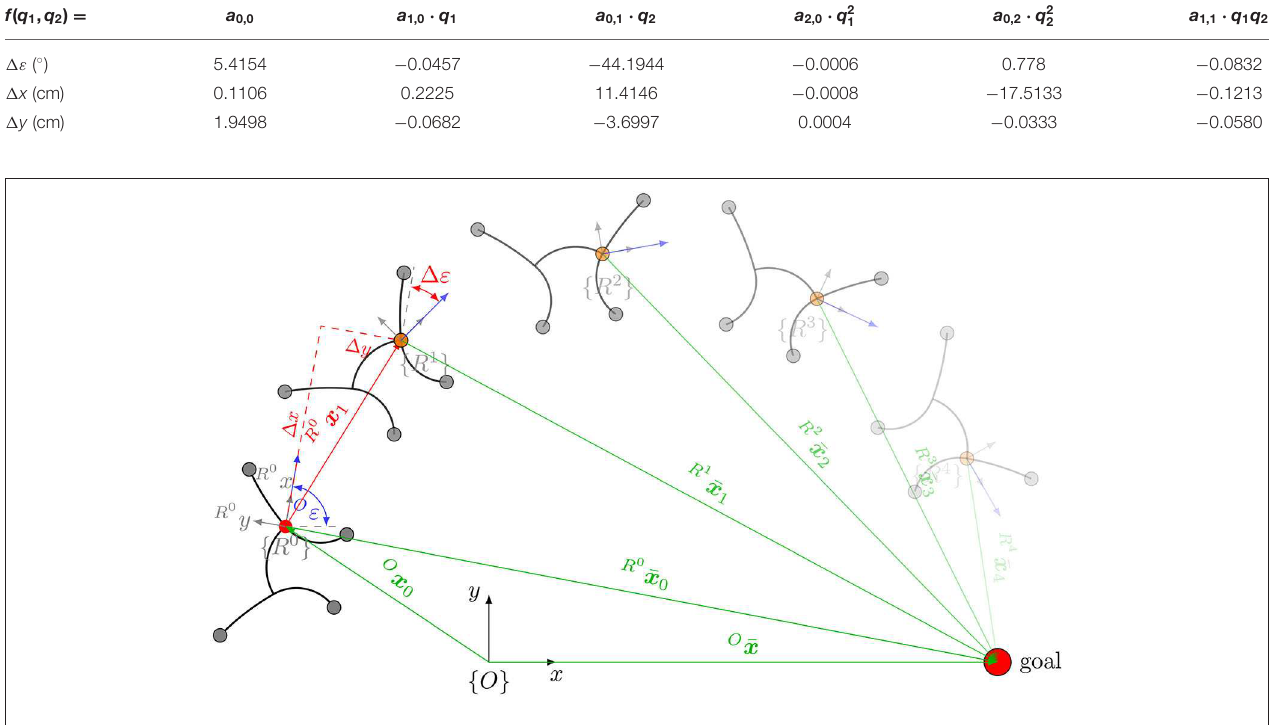
FIGURE 9 | Visualization of Equations (17)–(22). By using the approximation of the direct kinematics 1 x , the approximated position in Cartesian space after n cycles can be easily calculated. In the figure, the opacity decreases with increasing cycle